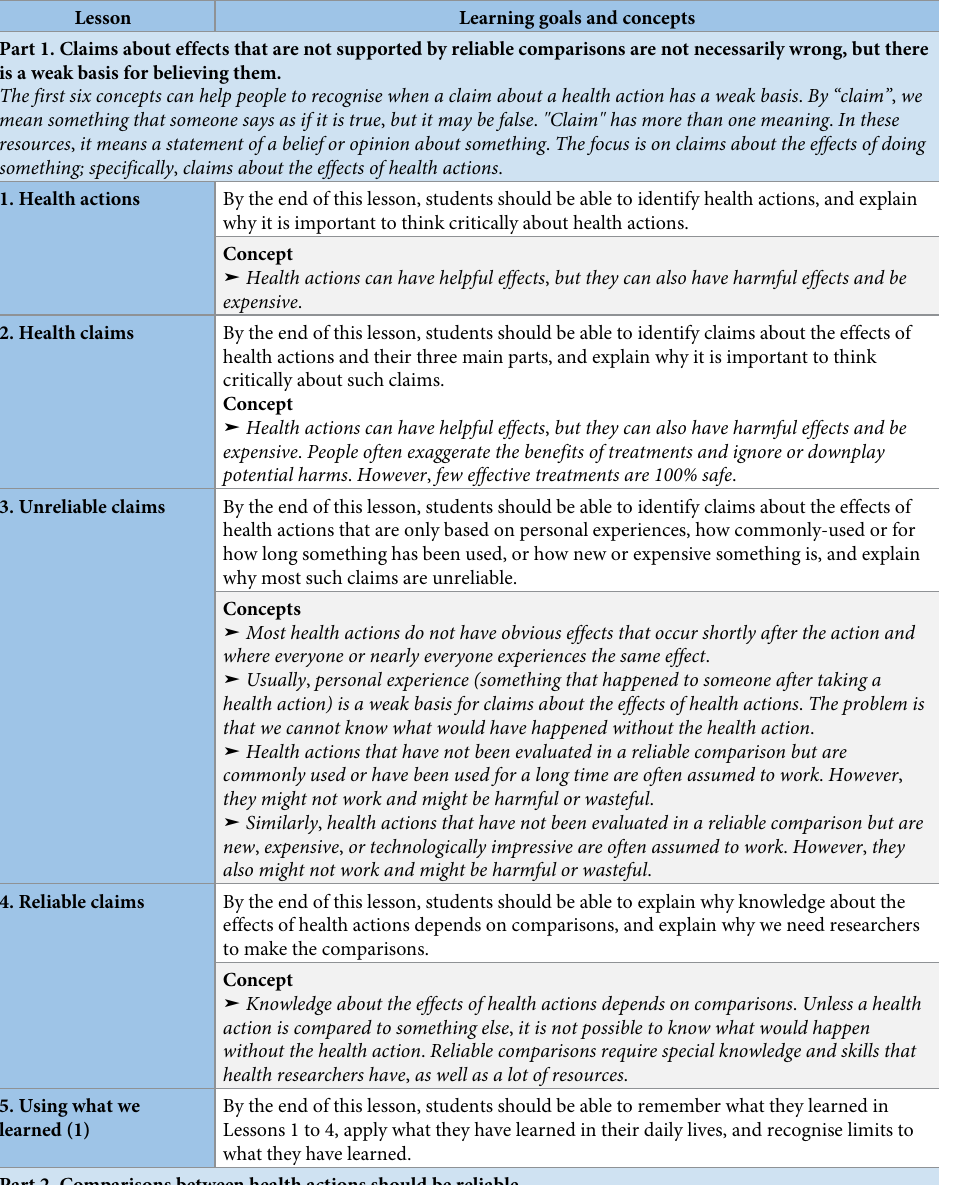
Table 8. Overview of the lessons.